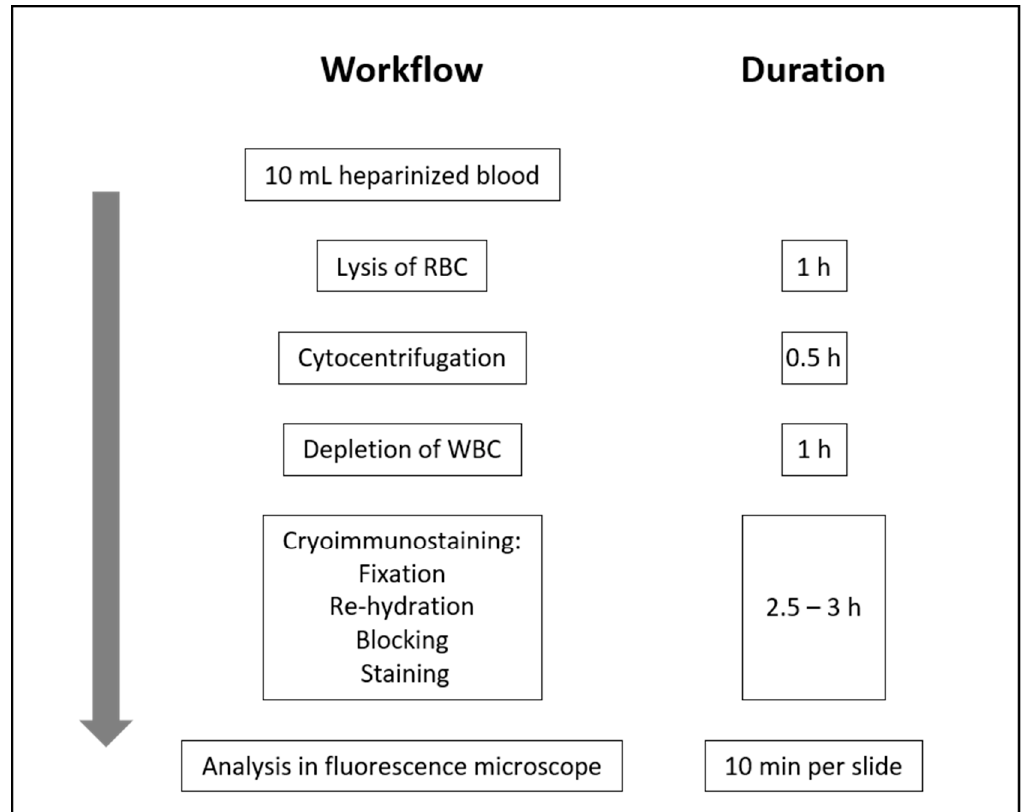
Figure 2. Workflow of tumour-associated circulating endothelial cell detection. WBC: white blood cells; RBC: red blood cells.